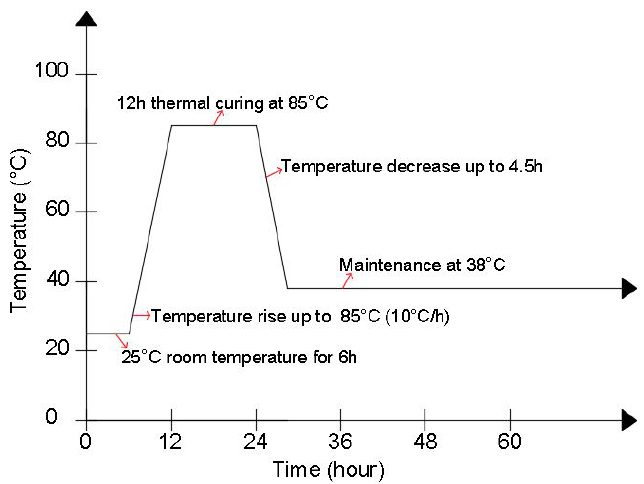
Figure 1. Curing process and environment exposure condition [16],